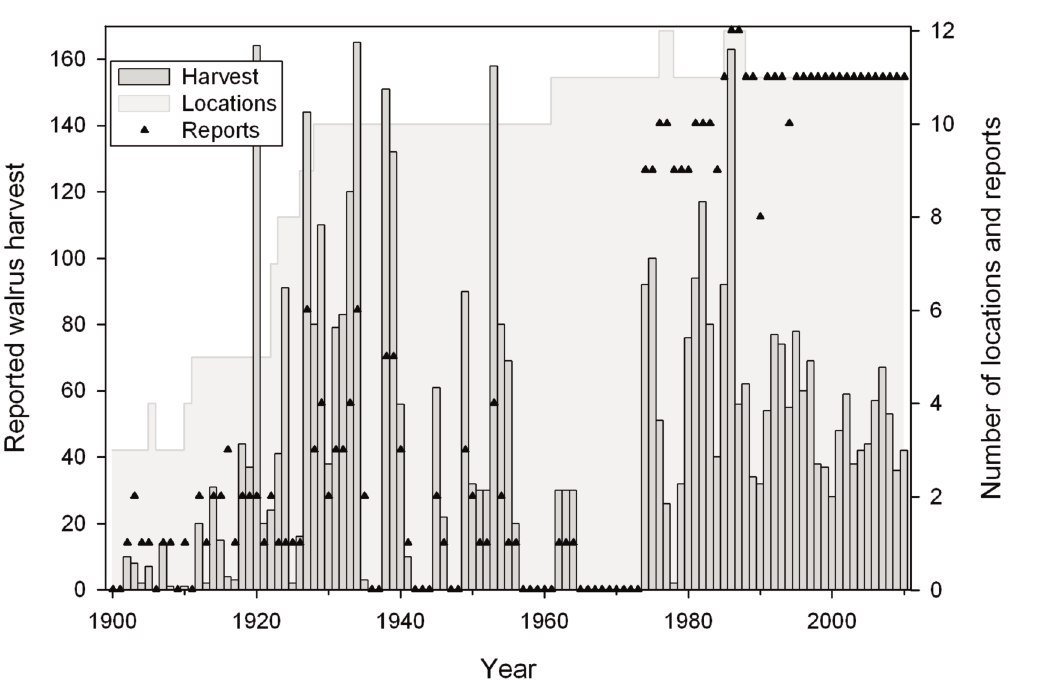
Fig. 23. Catches by Inuit and shore-based traders, and community reporting rates, from the South and East Baffin (SEB) stock of the Canadian Central Arctic walrus population, 1900–2010. Recent sport hunts not